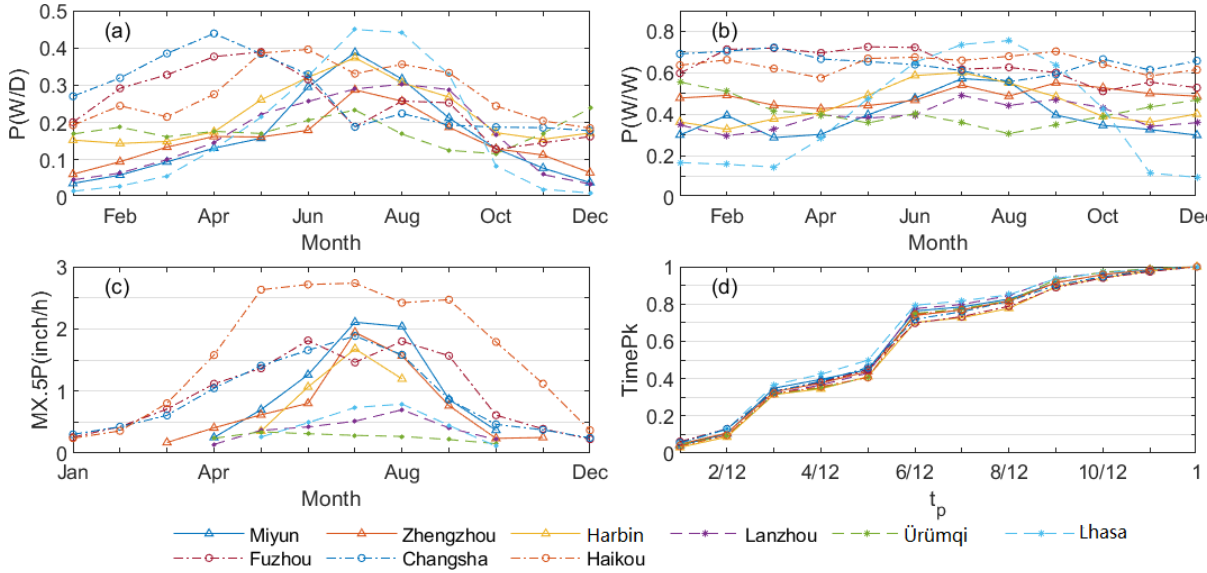
Figure 5. P ( W | D ), P ( W | W ), MX.5P, and TimePk of nine stations determined by observed daily precipitation. Table 3. Comparison of the accuracy of OK and UK using the leave-one-out cross-validation. CLIGEN inputs Observations RMSE c NSE d PBIAS d (%) AV a SD b OK UK OK UK OK